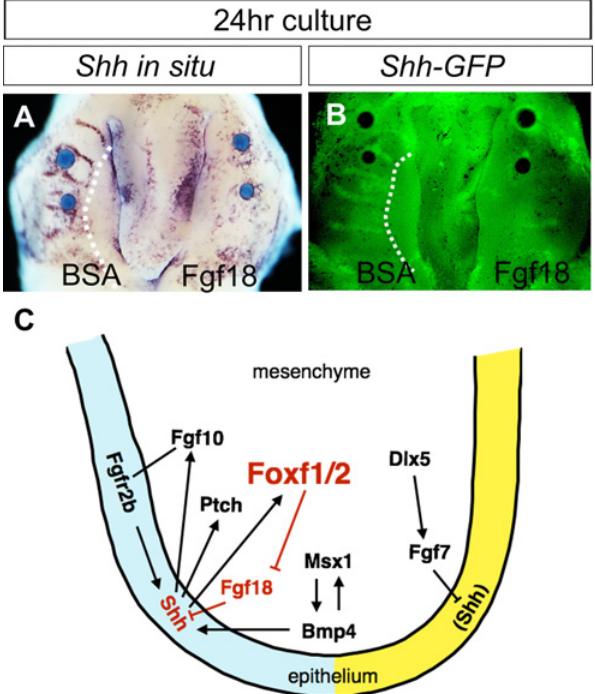
Fig 8. Regulation of Shh and Fgf18 expression during palate development. (A) Whole-mount in situ detection of Shh mRNAs in wildtype embryonic palatal explants treated with BSA beads (left side) and Fgf18 beads (right side). (B) The patterns of GFP expression in Shh GFP/+ embryonic palatal explants treated with BSA beads (left side) and Fgf18 beads (right side). Note that Shh expression is inhibited by Fgf18 beads. (C) A model depicting the molecular regulation of Foxf1 , Foxf2 , Fgf18 , and Shh expression in the developing palatal shelf. Regulation of Shh expression by Fgf10/Fgfr2b, Msx1/Bmp4, and Dlx5/Fgf7 pathways is summarized from References 8, 7, and 28,